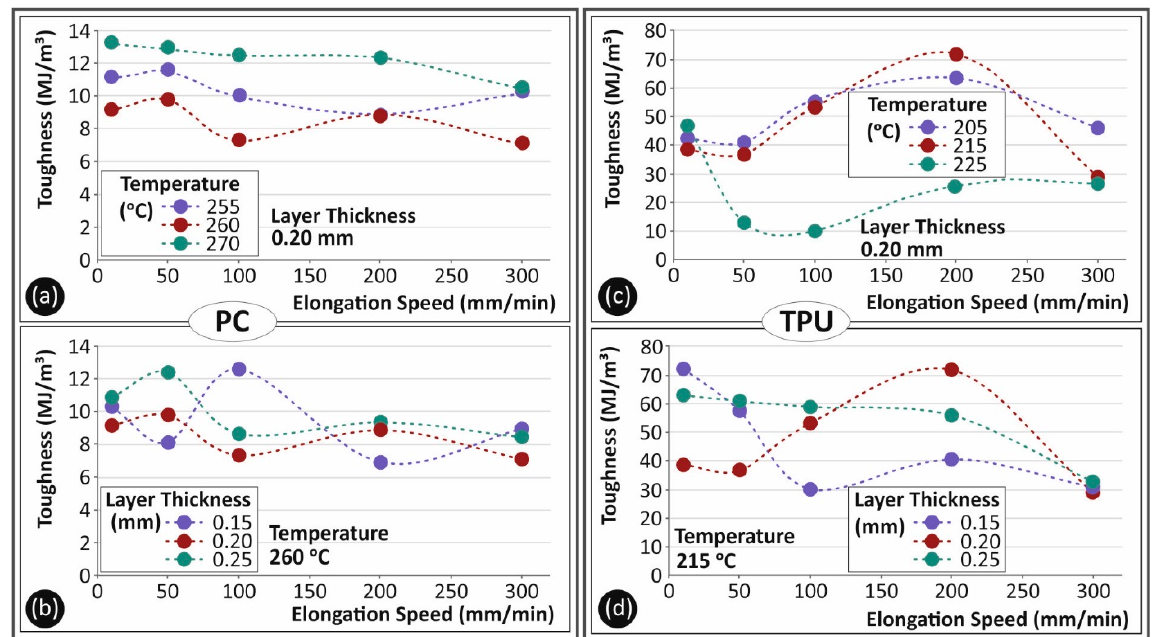
Figure 10. Toughness (MJ/m3) to elongation speeds tested (mm/min) for PC ( a , b ) and TPU ( c , d ) materials for the different temperatures ( a , c ) and the different layer heights ( b , d ) studied in this work.